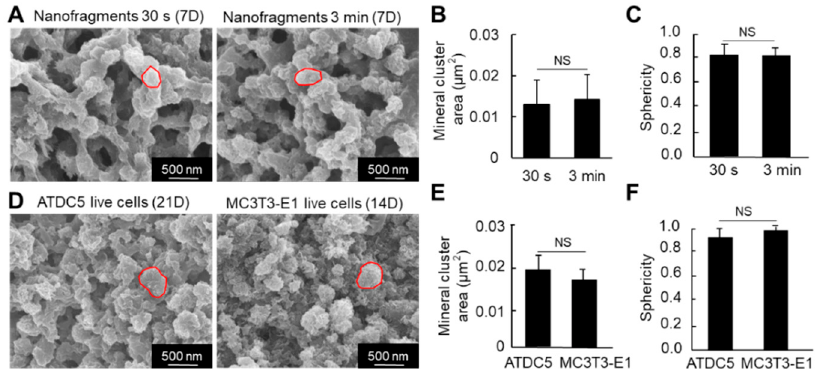
Figure 7. ( A ) SEM images of the mineral structures formed from cell nanofragment mineralization after treatment with NaClO to remove all organic material. ( B , C ) Graphs show the mineral cluster area ( B ) and the sphericity ( C ) of the minerals formed by the mineralization of cell nanofragments obtained by either 30 s or 3 min of ultrasonication. ( D ) SEM images of the mineral structures formed from ATDC5 and MC3T3-E1 live cells cultured for 21 and 14 days, respectively, in mineralization-inducing conditions. The minerals were treated with NaClO to remove all organic material. ( E , F ) Graphs show the mineral cluster area ( E ) and the sphericity ( F ) of the minerals formed by the mineralization of ATDC5 and MC3T3-E1 live cells. Note that the size and quasi-spherical shape of the minerals formed from the cell nanofragments were comparable to those formed by ATDC5 and MC3T3-E1 live cells. NS = non-significant, Student’s t -test.